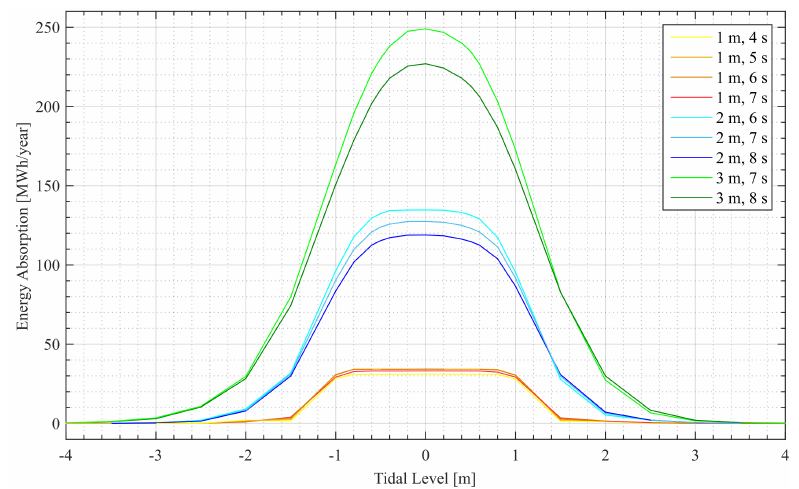
Figure 5. Annual energy absorption of the WEC at different tidal levels and for different combinations of H s and T e